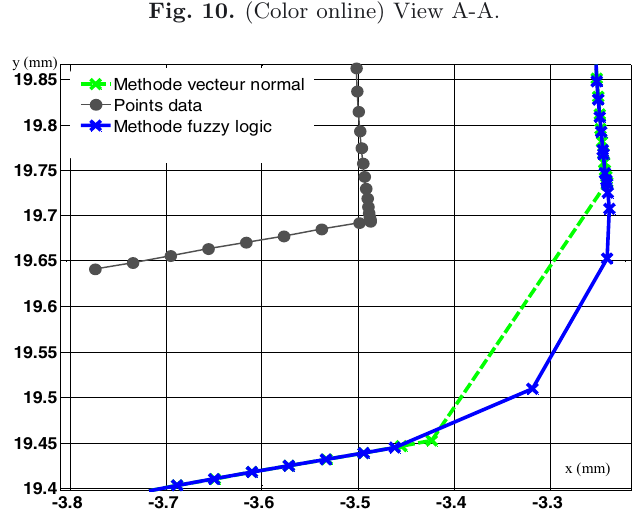
Fig. 11. (Color online) View